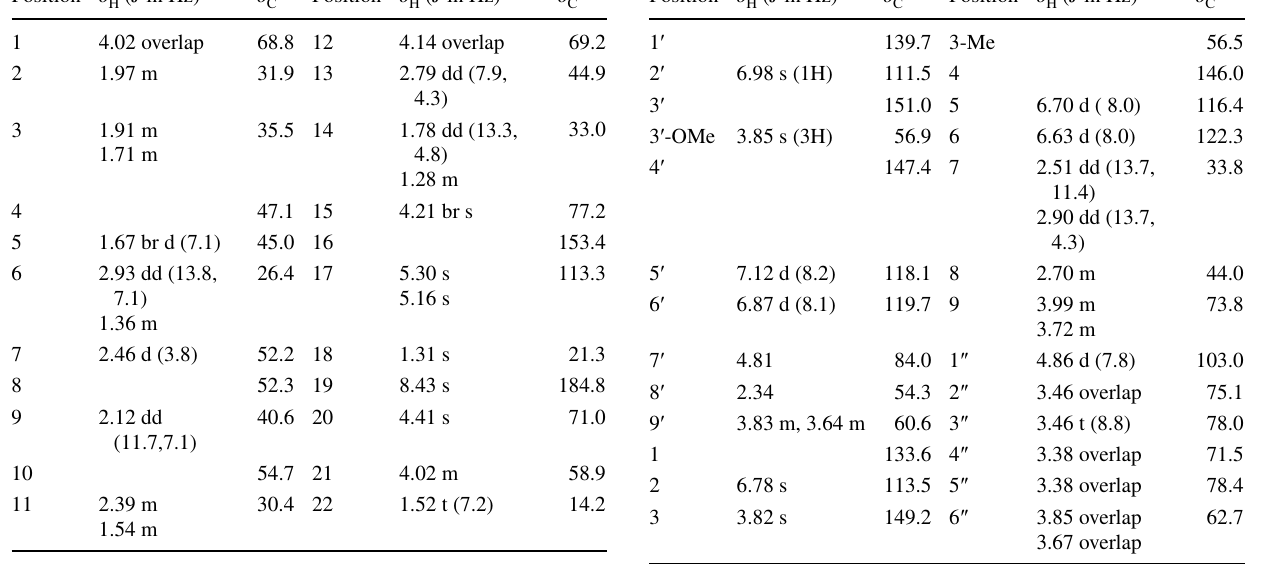
Table 2 NMR (400 MHz) spectroscopic data for Compound 1 in methanol- d 4 Position δ H ( J in Hz)